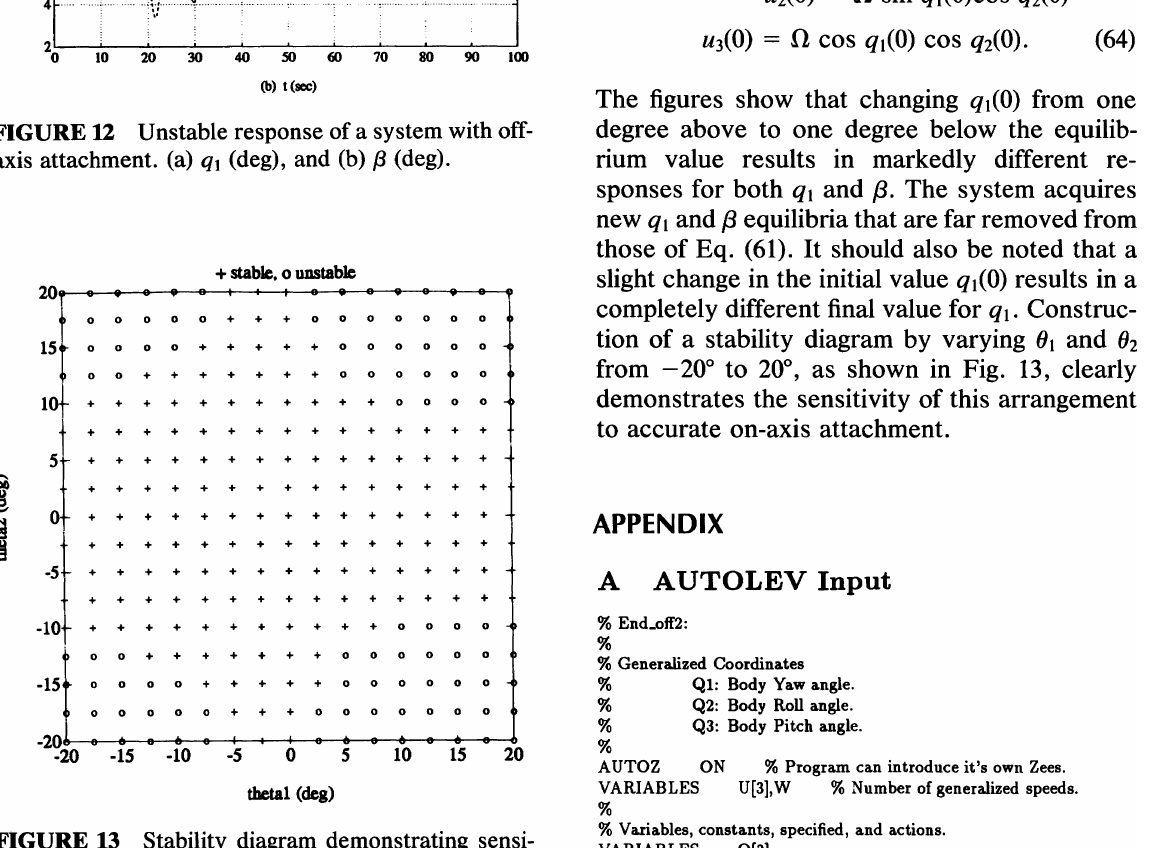
+ stable. 0 UDStable